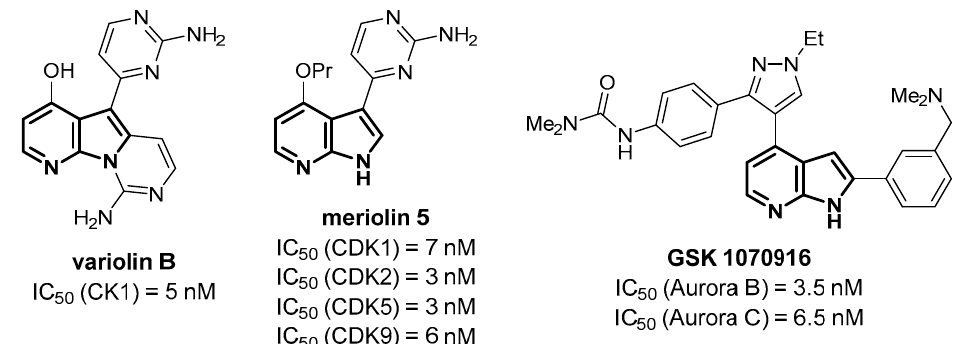
Figure 1. Compounds of biological interest containing a 7-azaindole core and their bioactivities.